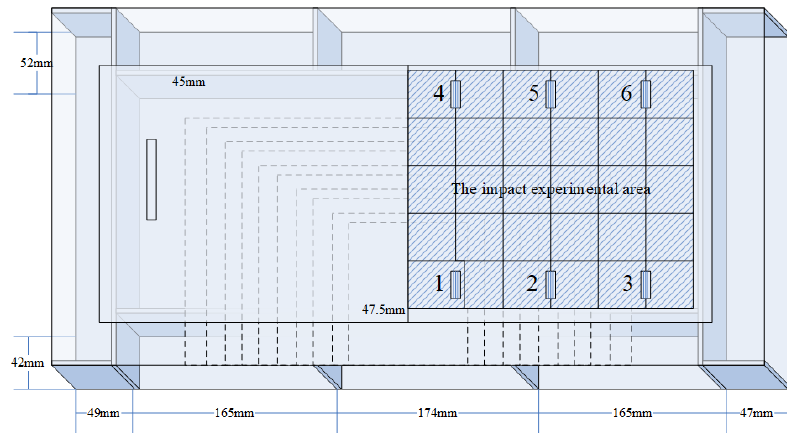
Figure 5. The variable thickness composite laminate on the tank surface.